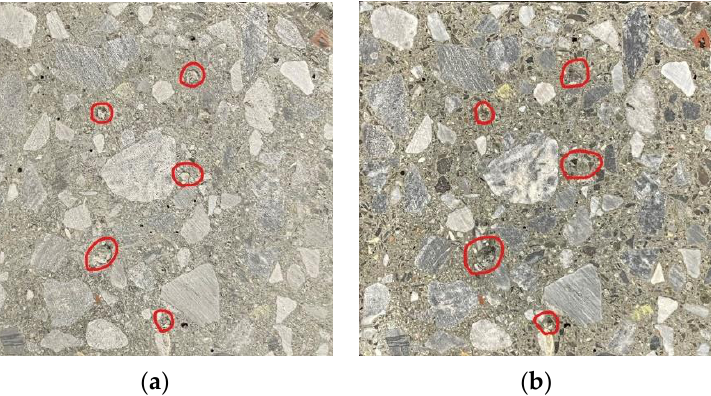
Figure 16. Cross-section appearance of specimen of C30WMS. ( a ) unwashed, ( b ) washed. As shown in Figure 17, we have compared the surface of three concrete specimens of C30 strength grade after 250 freeze–thaw cycles; thus, it is obvious that the surface of C30WMS specimen suffers the most severe damage, which indicates that the clay lumps in WMS have a significant adverse effect on the freeze resistance of concrete.